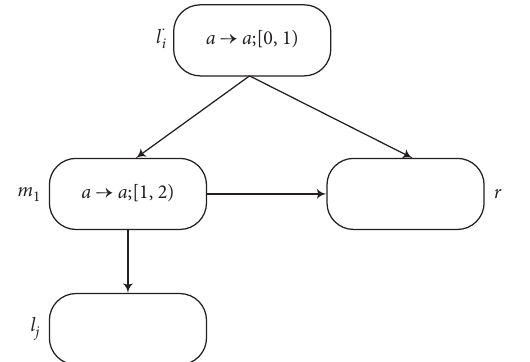
Figure 6: Module ADD’: simulating the ADD ′ instruction l